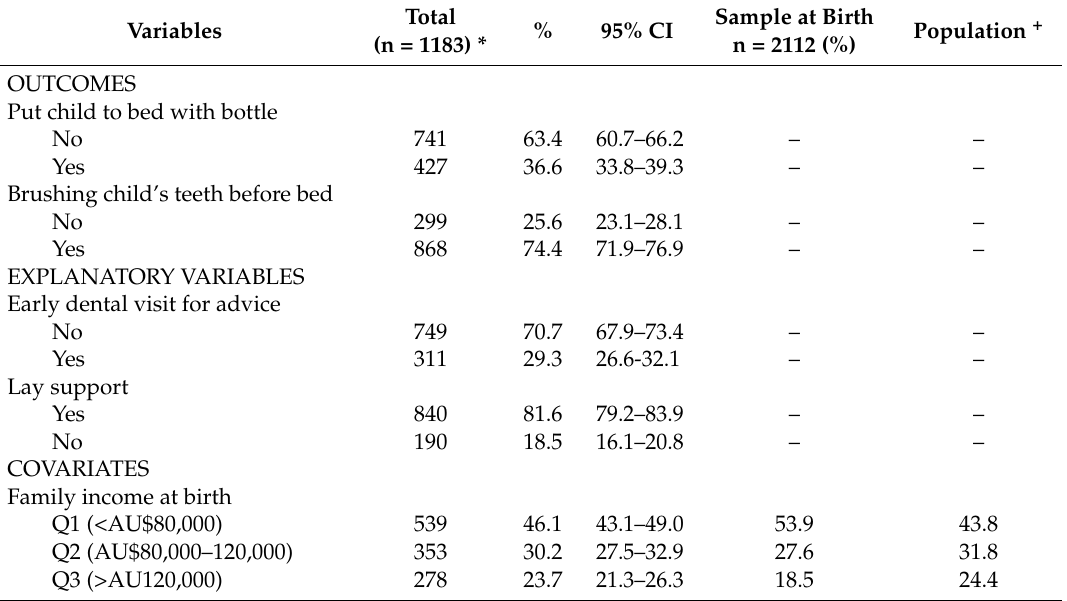
Table 1. Descriptive statistics of the study